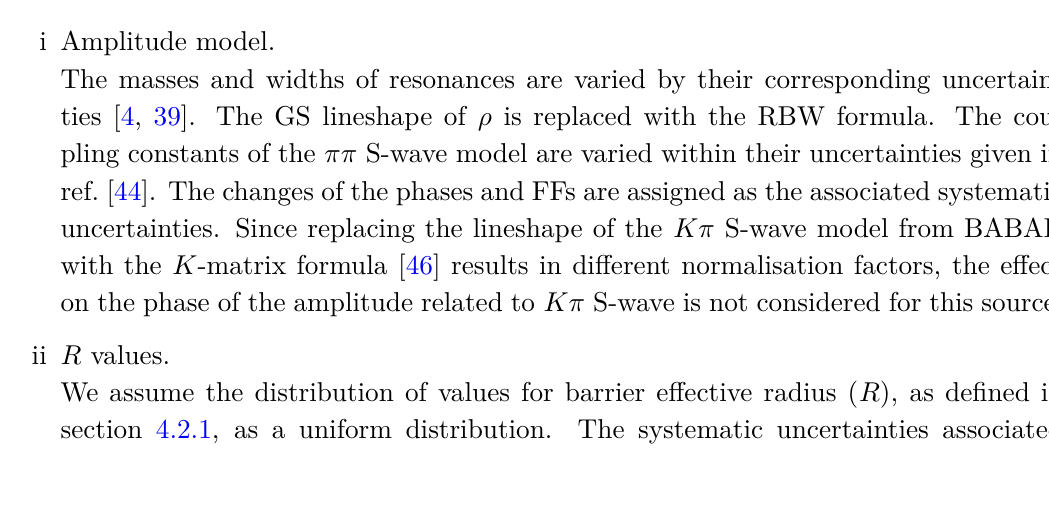
Table 8 . Phases, FFs, and statistical significances for different amplitudes. Groups of related amplitudes are separated by horizontal lines. The last row of each group gives the total fit fraction of the above components with interferences considered. The amplitudes K are constructed by two sub-amplitudes with fixed relations (see appendix B). The K ∗ 0(+) resonance decays to K + π − (0) . The ρ +(0) resonance decays to π + π 0( − ) . The ω resonance decays to π + π − π 0 . Note that K ∗ indicates K ∗ + and K ∗ 0 , ρ indicates ρ + and ρ 0 . The first and second uncertainties in the phases and FFs are statistical and systematic, respectively. The total FF is